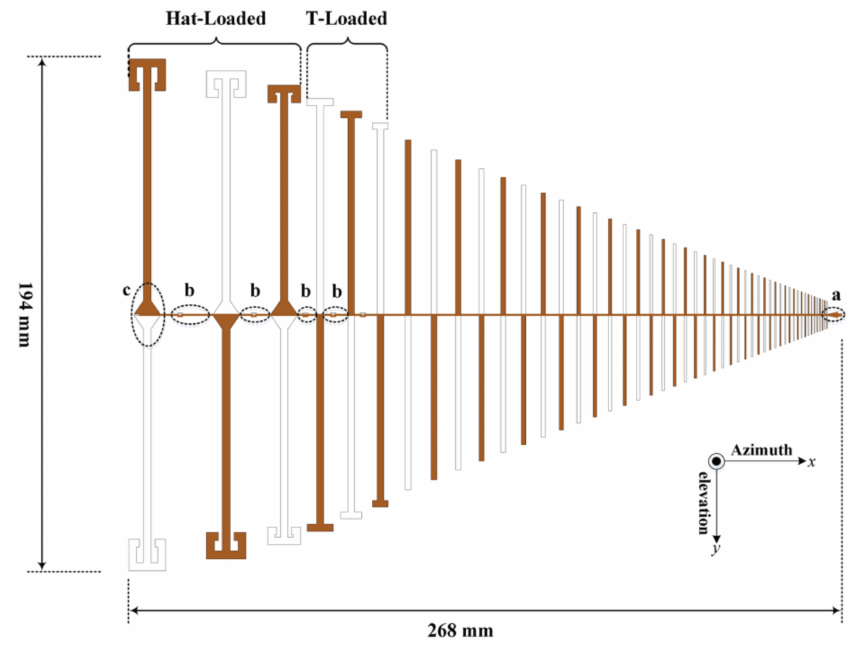
Figure 1. PLPDA design with implemented hat-loading and T-loading techniques in